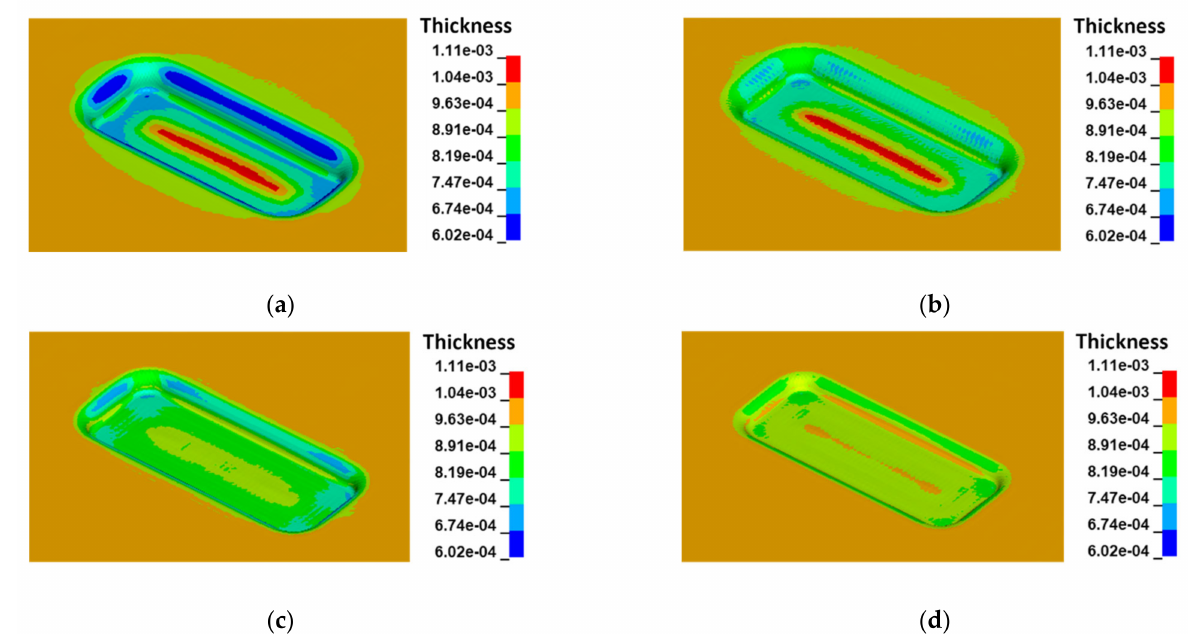
Figure 8. Final thickness of EMF for ( a ) CASE 1, ( b ) CASE 2, ( c ) CASE 3, and ( d ) CASE 4.